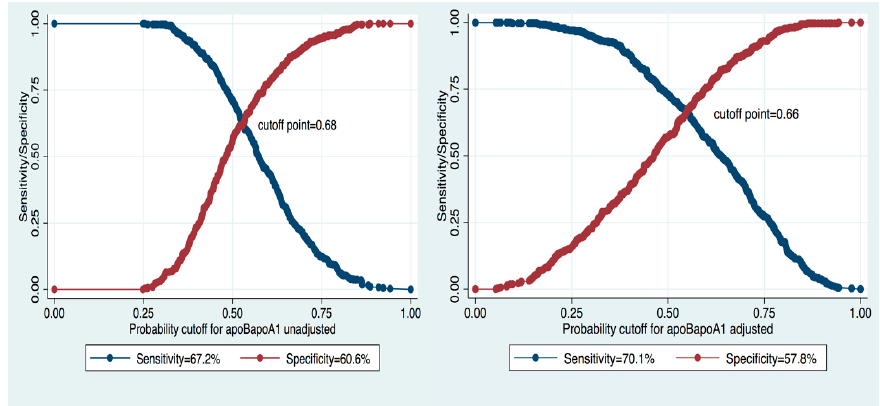
Figure 2. Cutoff point, sensitivity, and specificity of Apo/ApoA1 ratio in unadjusted and adjusted models.